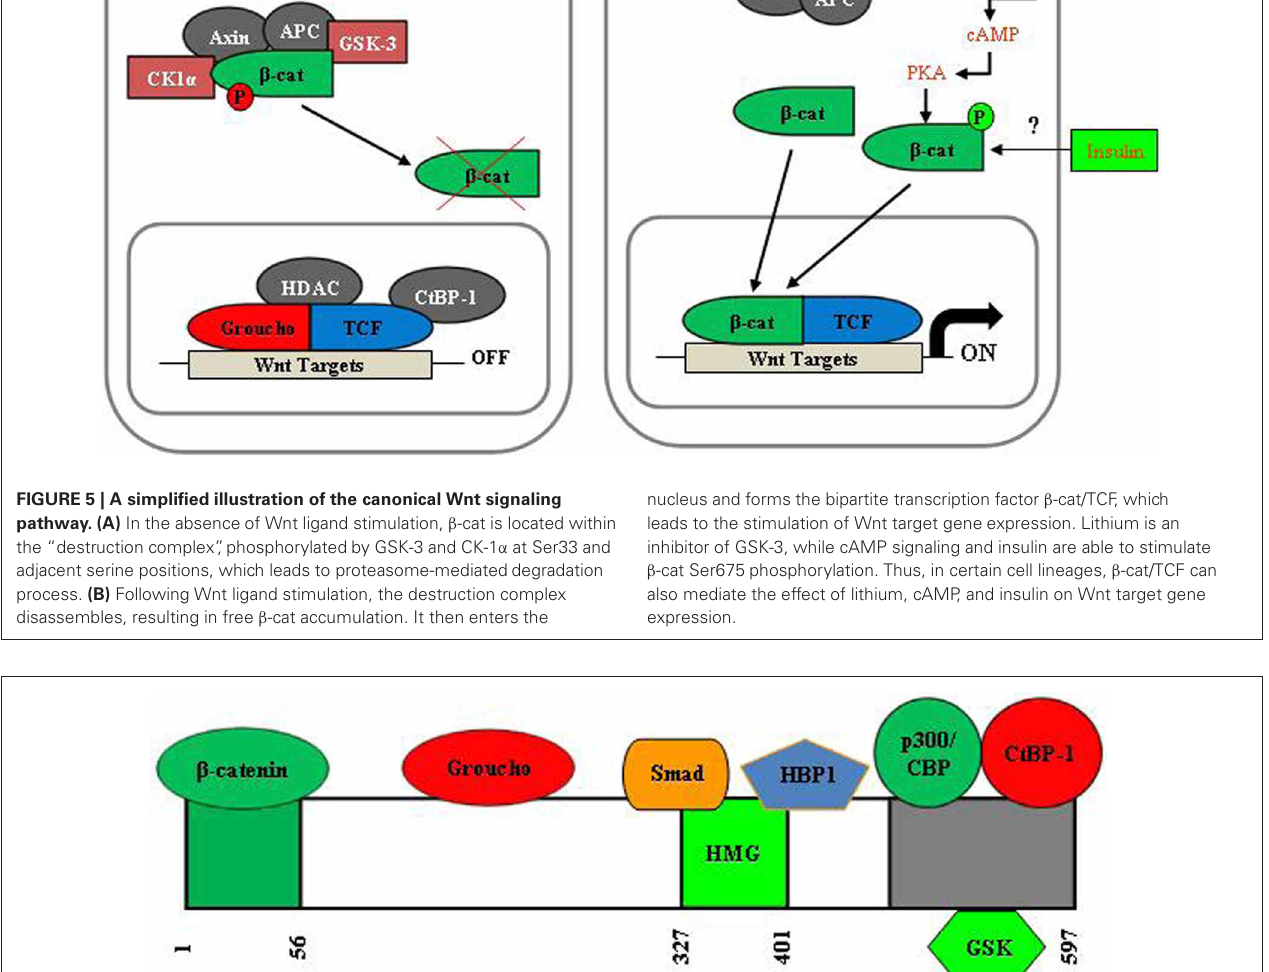
FIGURE 6 | Structure and functional domains of human TCF7L2. It is currently unclear which position of the domains that interact with Groucho and CtBP1. Smad4 is the major mediator of the TGF β signaling cascade. HBP1, HMG-box transcription factor 1, a transcriptional